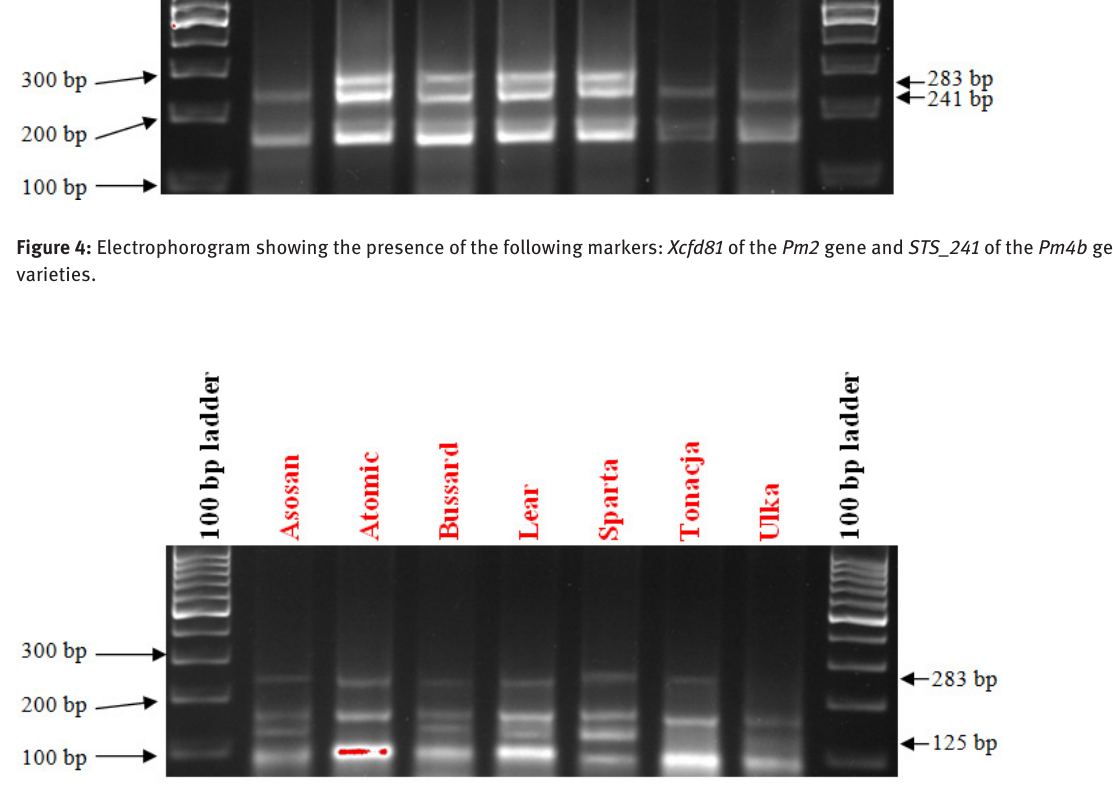
Figure 5: Electrophorogram showing the presence of the following markers: Xcfd81 of the Pm2 gene and STS_241 of the Pm4b gene in wheat